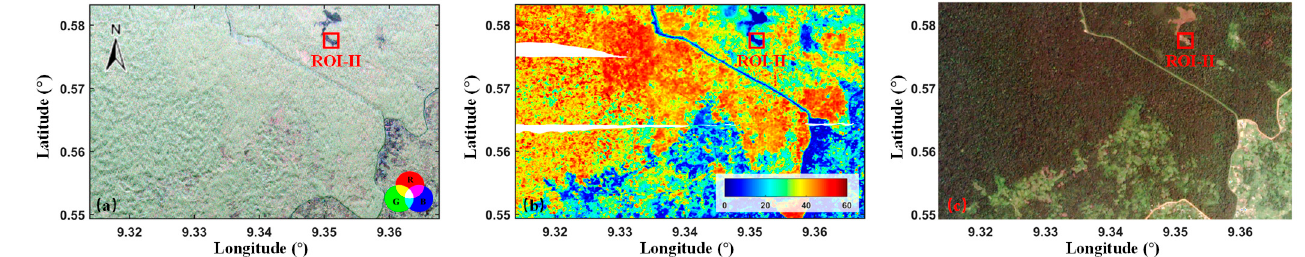
Figure 3. Mondah study area: ( a ) average of master and slave PauliRGB images; ( b ) LiDAR CHM; ( c ) optical image. Table 1. System parameters for Mabounie and Mondah from the AfriSAR 2016 campaign.